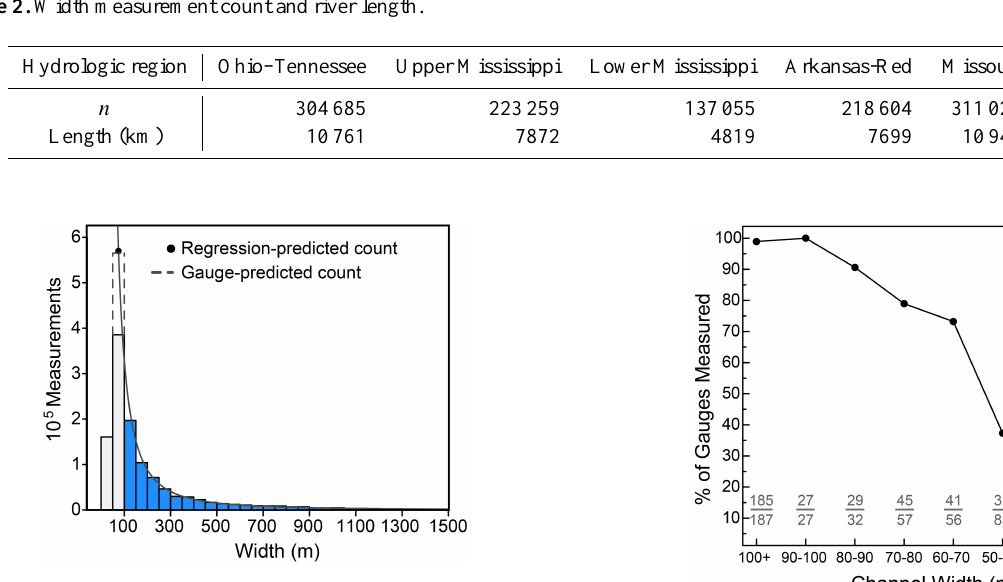
Figure 6. Width distributions for all rivers >100m (blue bars) and all measured rivers <100m (gray bars); black circle represents measurements predicted by the 100–1500m distribution regression ( n = 570000, black line); dashed gray lines show estimated number of 50–100m rivers from the frequency distribution of USGS river gauges ( n = 565000).